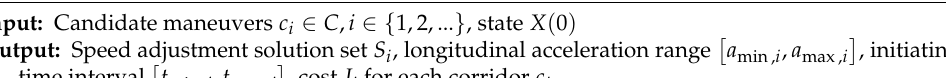
Algorithm 1 Maneuver